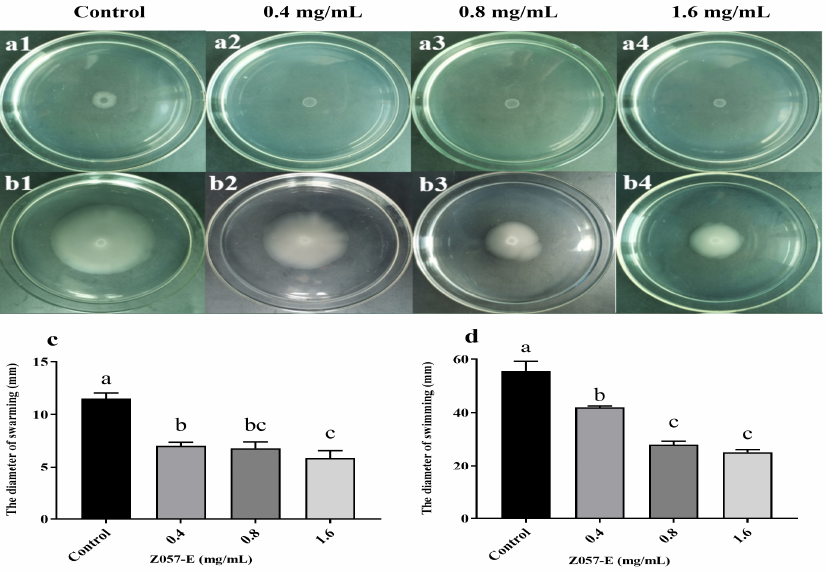
Figure 4. The effects of Z057-E on swarming ( a1 – a4 , c ) and swimming ( b1 – b4 , d ) abilities of V. parahaemolyticus . Significant differences ( p < 0.05) are indicated by different letters (a, b, and c). 3.5. Effect of Z057-E on the Activity of Signal Molecule AI-2 of V. parahaemolyticus Autoinducer-2 (AI-2) is considered a universal language for intraspecies and interspecies communication, and it is related to the formation of V. parahaemolyticus biofilm [7]. As shown in Figure 5, Z057-E could significantly and dose-dependently inhibit the synthesis of AI-2. Moreover, following the exposure to 0.8 and 1.6 mg/mL of Z057-E, the AI-2 productions were reduced by 56.52% and 66.69%, respectively. Figure 5. The effect of Z057-E on AI-2 activity, EPS, and extracellular protein synthesis of V. parahaemolyticus . Significant differences ( p < 0.05) are indicated by different letters (a, b, and c). 3.6. Effect of Z057-E on EPS, Extracellular Protein of V. parahaemolyticus Biofilm EPS and extracellular protein are the main components of bacterial biofilm, and perform many functions, including promoting adhesion to surfaces, constructing and